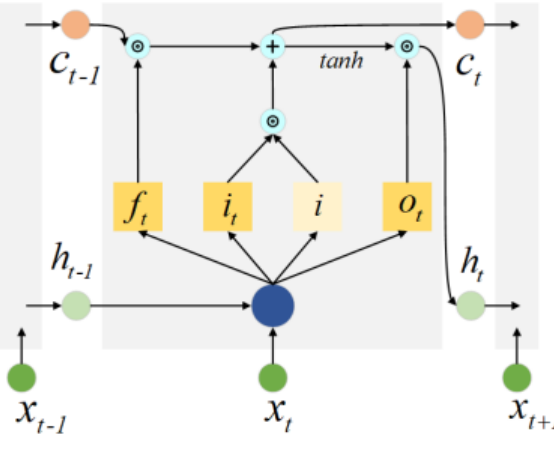
Figure 3. The internal structure of an Long Short-term Memory (LSTM) unit where (cid:12) and ⊕ denote element-wise product and addition of two vectors,